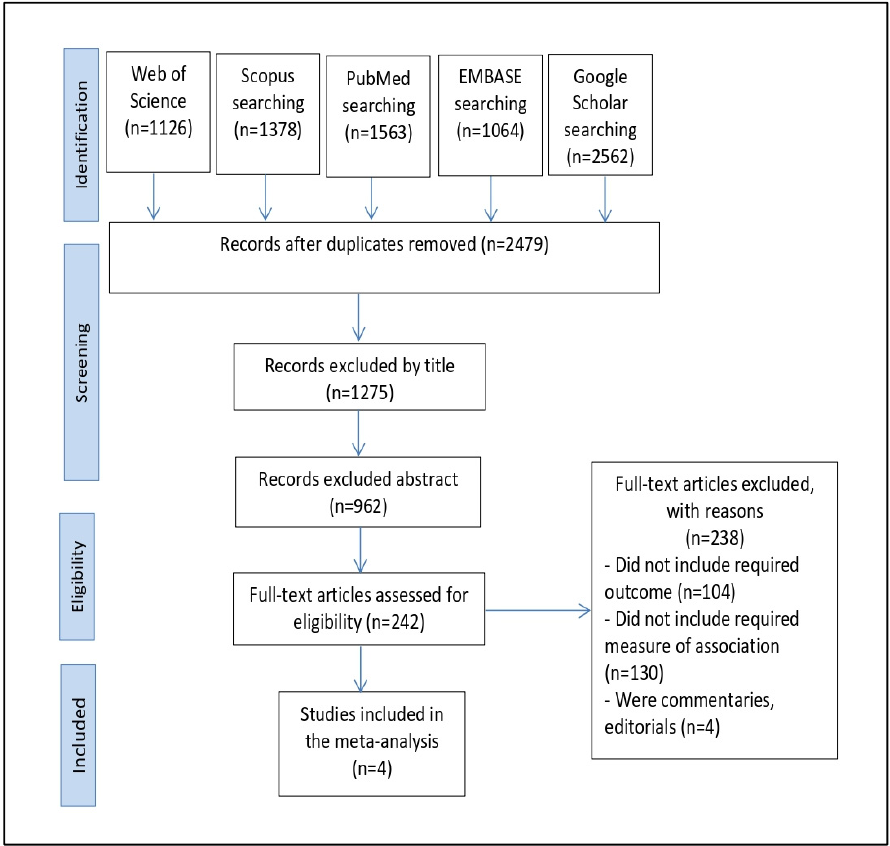
Figure 1. The PRISMA flowchart for the process of selecting and identifying studies.